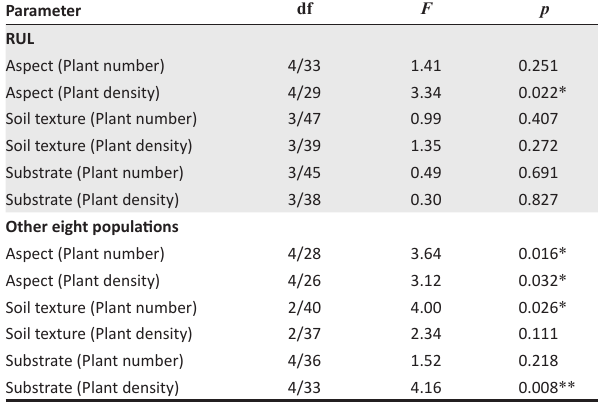
FIGURE 4: Principal component analysis showing the relationship between number of plants (Number), occupied area (Area) and habitat parameters: altitude, aspect (LEVEL, W, SW, S+SE+E, N+NE+NW), coastal distance, gradient (degree of slope), soil texture (loamy sand, silt loam, sand) and substrate (Quartz + other, Schist + other, Pegmatite + other, Feldspar + other, Granite + other) in the 43 sites of the other eight populations. TABLE 3: Importance of three habitat parameters (aspect, soil texture and substrate) for plant number and plant density determined with analysis of variance and Tukey pairwise comparisons, for 51 sites at Rössing Uranium Limited and for 43 sites at the other eight